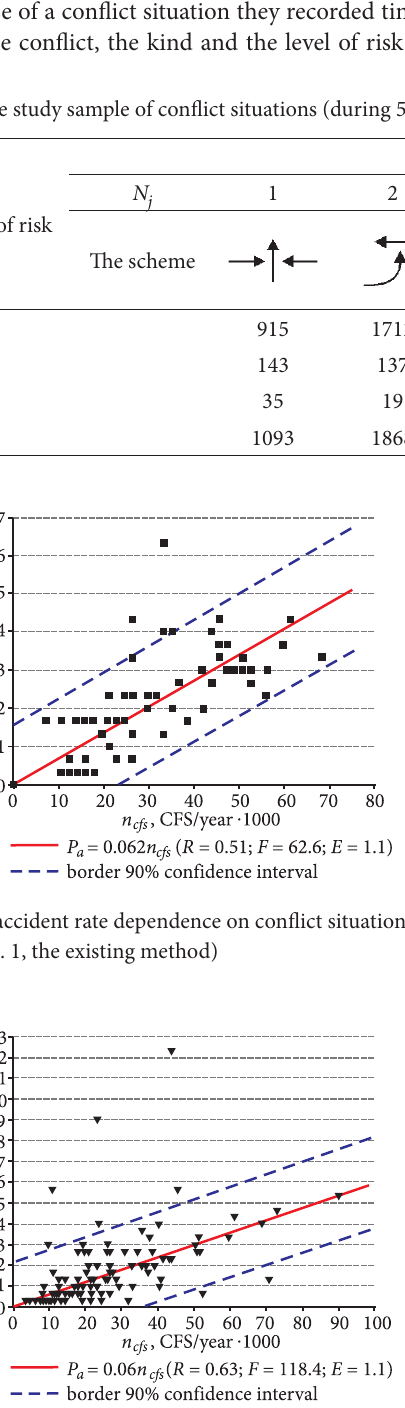
Fig. 3. The accident rate dependence on conflict situations (conflict No. 3, the existing method)